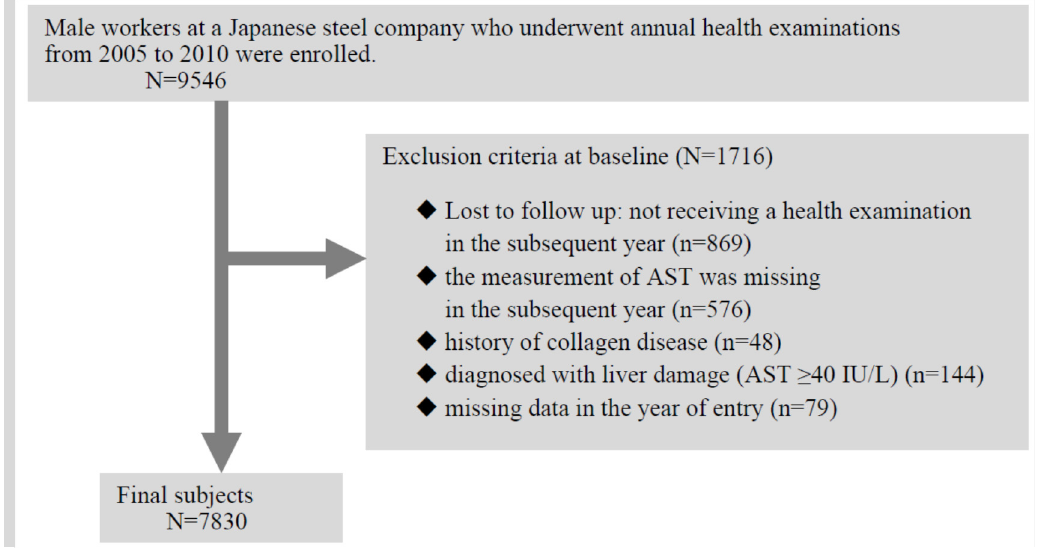
Figure 1. Flow diagram of study subjects.